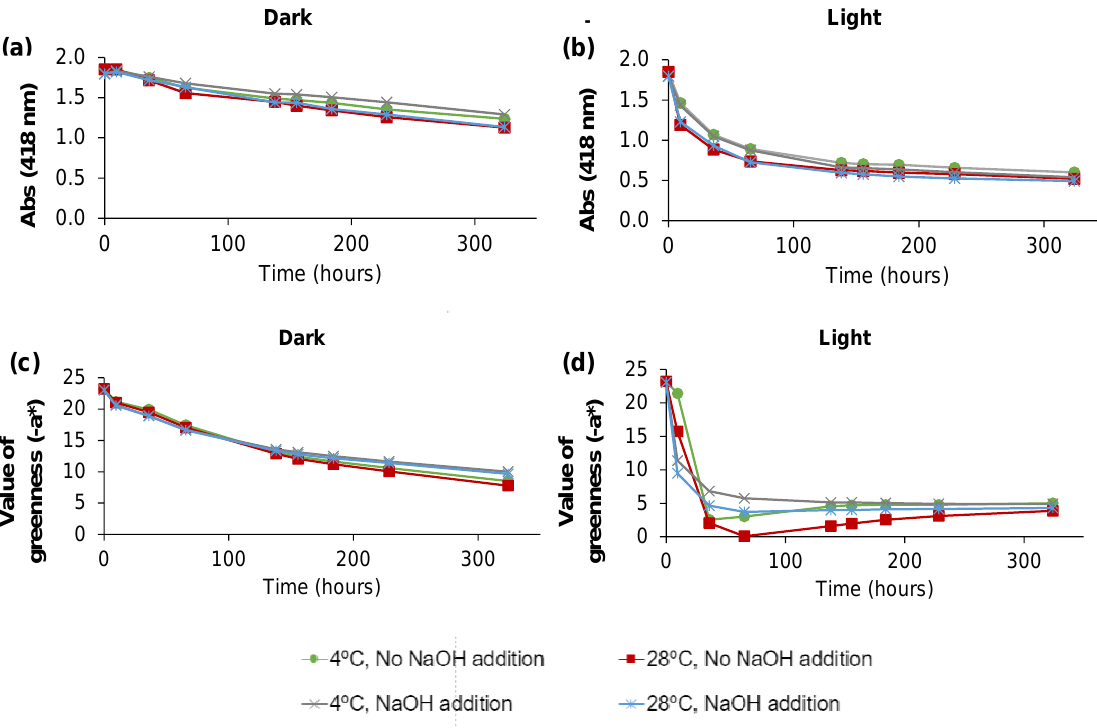
Figure 6. Absorbance (418 nm) measured over time for the 8 experimental conditions ( a ) in the dark, and ( b ) in the light. Value of greenness ( − a*) measured over time for the 8 experimental conditions ( c ) in the dark, and ( d ) in the light. To understand the influence of pigments concentration on their degradation rate, the degradation at 4 ◦ C with and without NaOH in the dark and in the presence of light was evaluated. Hence, the analyzed parameters at 48 h were estimated (Table